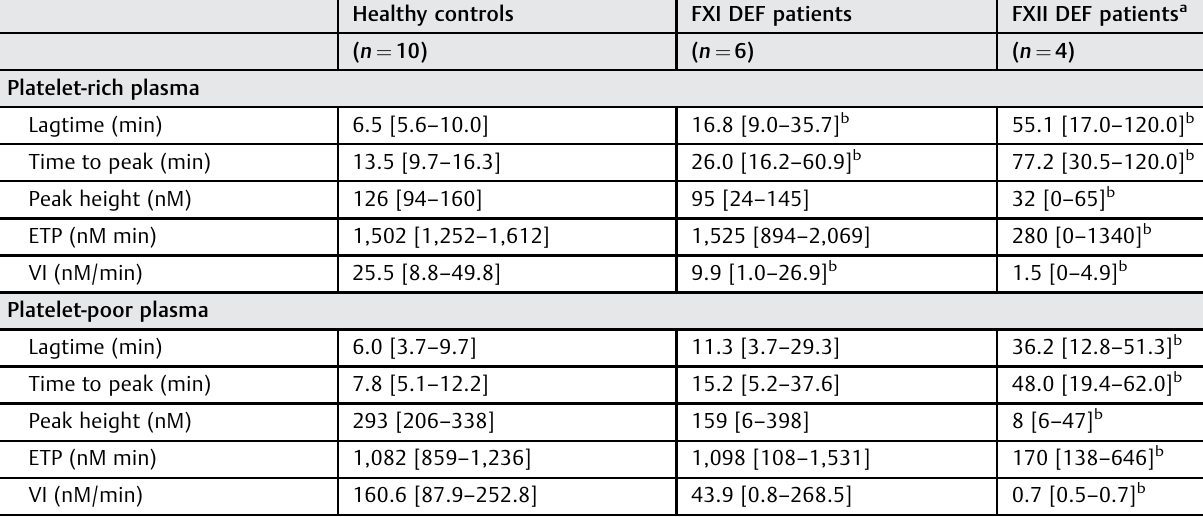
Table 2 Thrombin generation in platelet-rich plasma and platelet-poor plasma — contact